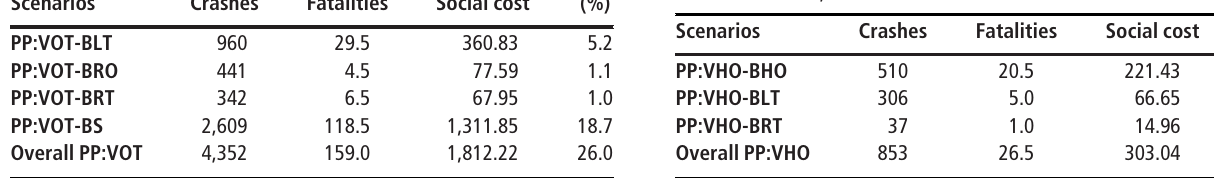
Table III Crashes, fatalities and social cost of